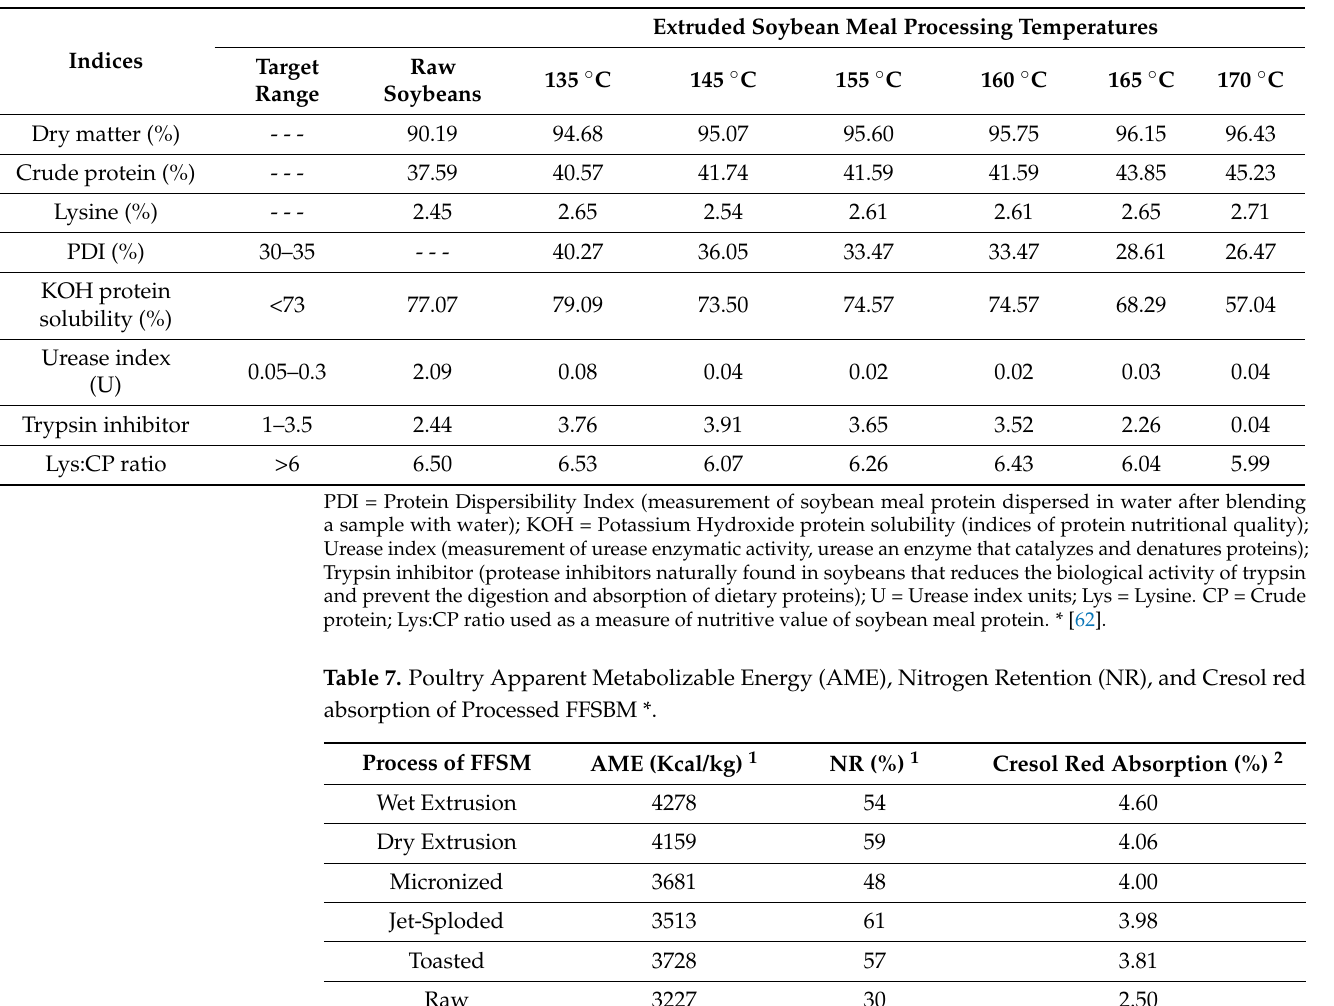
Table 6. Quality indices of raw soybeans and extruded soybeans at different die temperatures *.